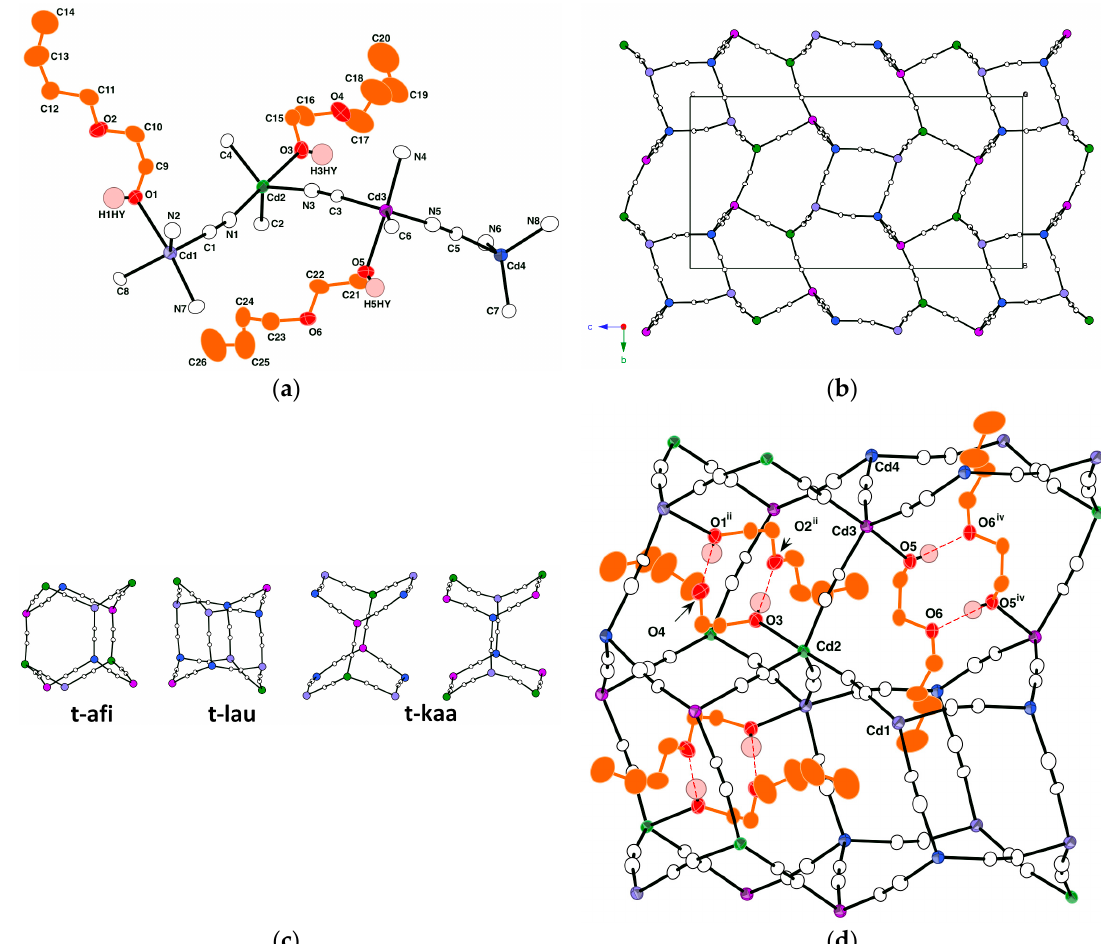
Figure 2. Crystal structure of II . H atoms except OH hydrogens and disorder parts are omitted for clarity: ( a ) Asymmetric unit. Displacement ellipsoids are drawn at the 30% probability level. Because arrangements of cyanides (Cd–NC–Cd or Cd–CN–Cd) are disordered, the atoms of cyanide are labeled less clearly; ( b ) The Cd(CN) 2 network structure of the view along the a axis; ( c ) [6 5 ] t-afi , [4 2 .6 4 ] t-lau and [6 2 .8 2 ] t-kaa tiles; ( d ) Hydrogen bonds between neighboring Bucel ligands in cavities of cadmium cyanide network of II . Displacement ellipsoids are drawn at the 30% probability level. (Symmetry codes: ii = − x + 1, y − 1/2, − z + 1/2; iv = − x + 1, − y + 1, − z ).